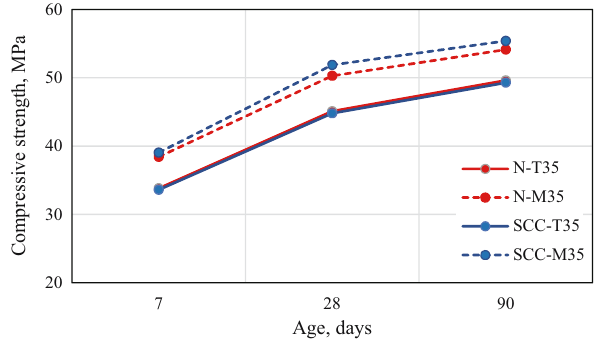
Figure 10: Compressive strength improvement using magnetized water instead of tap water for all mix.